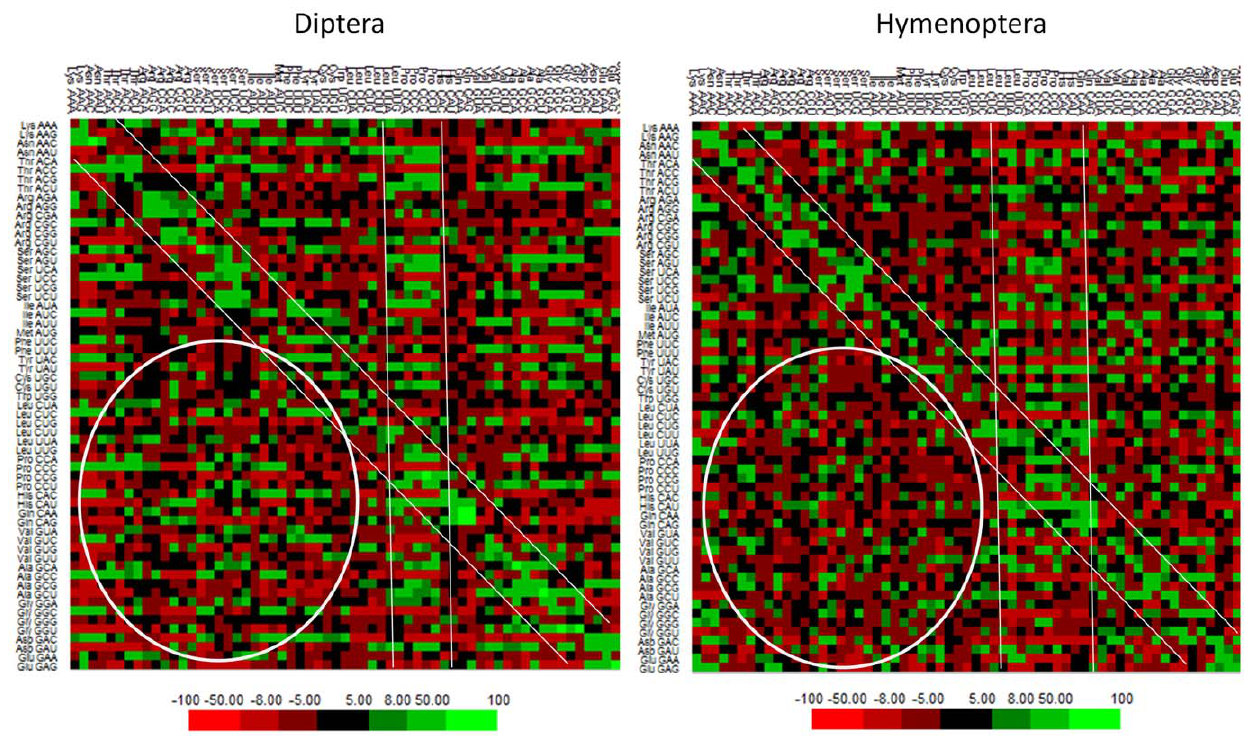
Figure 3. Patterns of codon context variation in dipteran and hymenopteran insects. The cluster pattern is based on average matrix of residuals of each codon context among the species of each order. The 5 9 codons are in rows and the 3 9 codons are in columns. The green color represents highest number of the contexts and red color represents the lowest number of contexts (scale is shown below the figure).